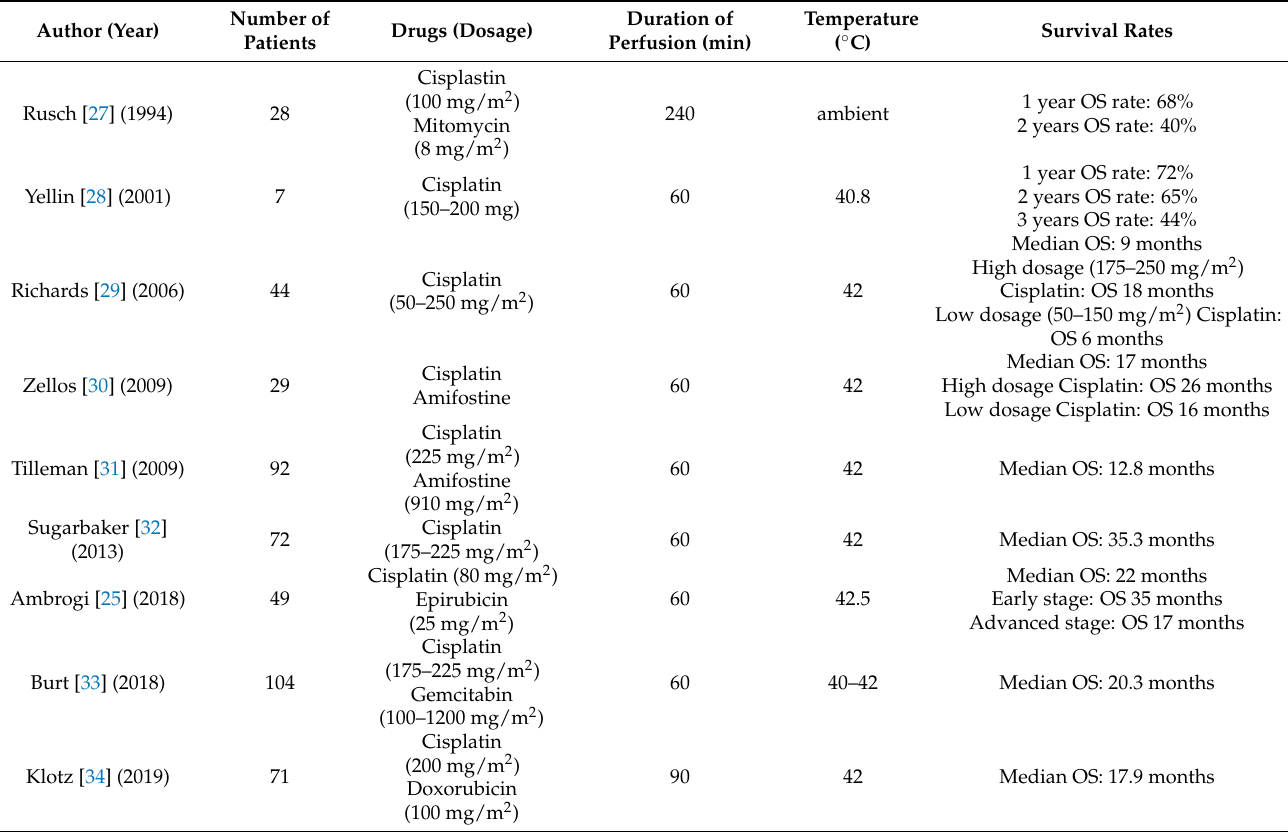
Table 2. HITHOC protocols used and oncological outcomes. OS = Overall